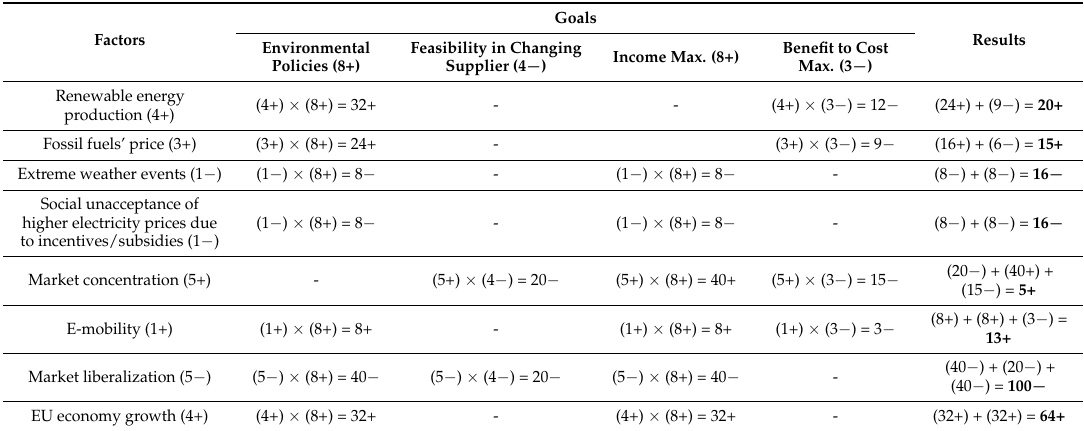
Table 6. Results calculation for the multiple-criteria decision analysis: influence of the external factors on the goals of the most relevant market